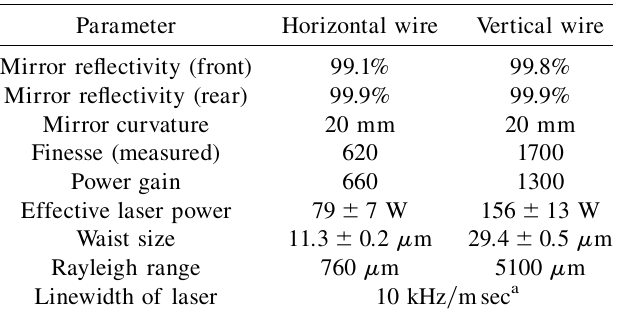
TABLE I. Specifications of the optical